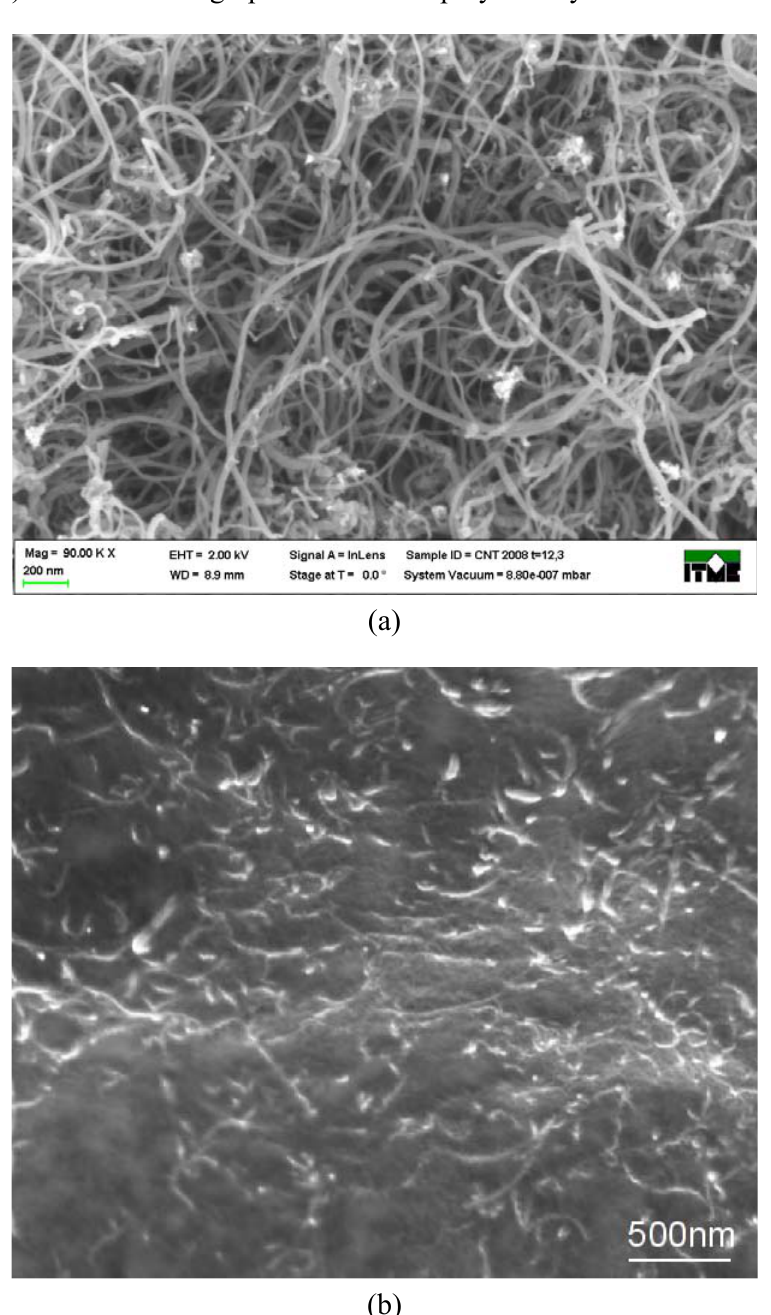
Figure 3. (a) HRSEM micrograph of MWCNT material used in screen-printing paste preparation. (b) HRSEM micrograph of MWCNT polymer